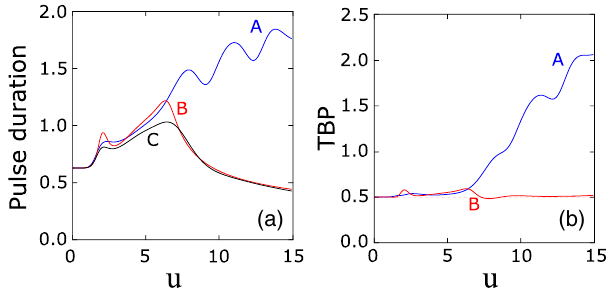
FIG. 5. (a) Duration of the pulse represented in Fig. 1(a); line A (blue) represents the r.m.s. pulse duration from the integration of Eq. (1); line B (red) represents the r.m.s. duration of a Gaussian distribution (in power) with the same f.w.h.m. of the pulse; line C (black), represents the duration of a Fourier transform limited Gaussian with the r.m.s. spectral width calculated from the spectral distribution in Fig. 3. (b) Time-bandwidth product (TBP) calculated from the r.m.s. duration and spectral width (A-blue) and from the scaled f.w.h.m duration and the r.m.s. spectral width (B-red), are completely different after saturation.